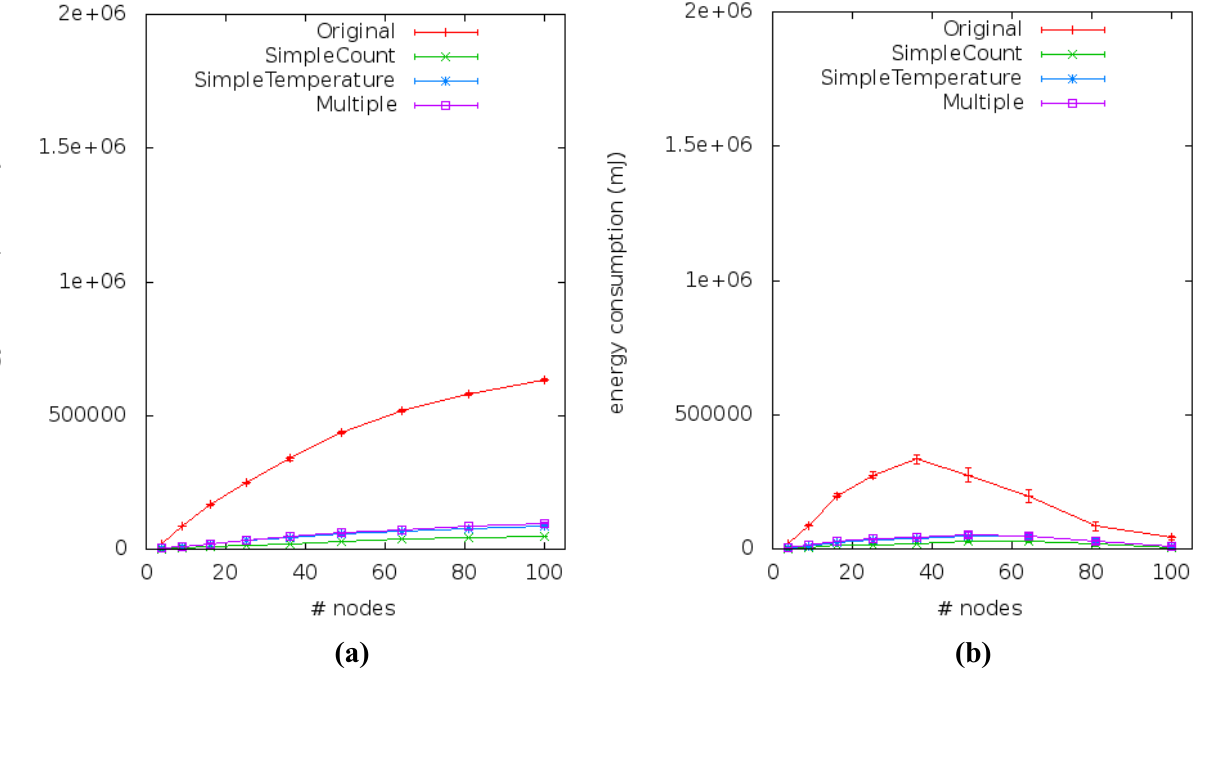
Figure 15. Average energy of the radio consumed by messages received for gossip routing: (a) Scenarios #1 and #2. (b) Scenarios #3 and #4. (c) Scenarios #5 and